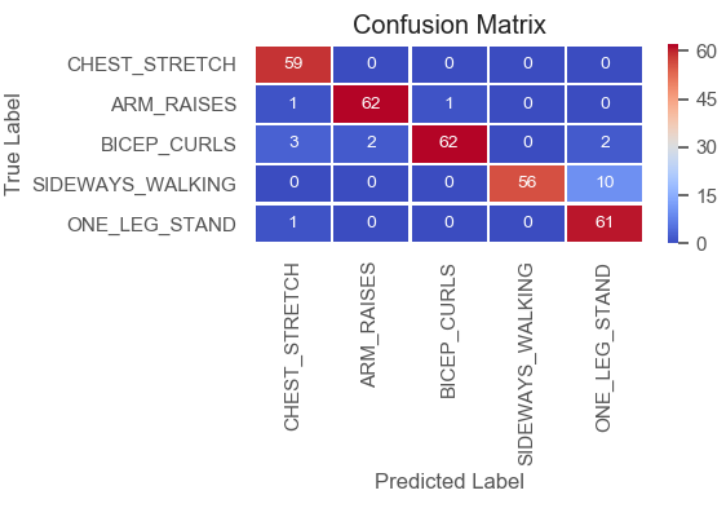
Figure 14. Confusion